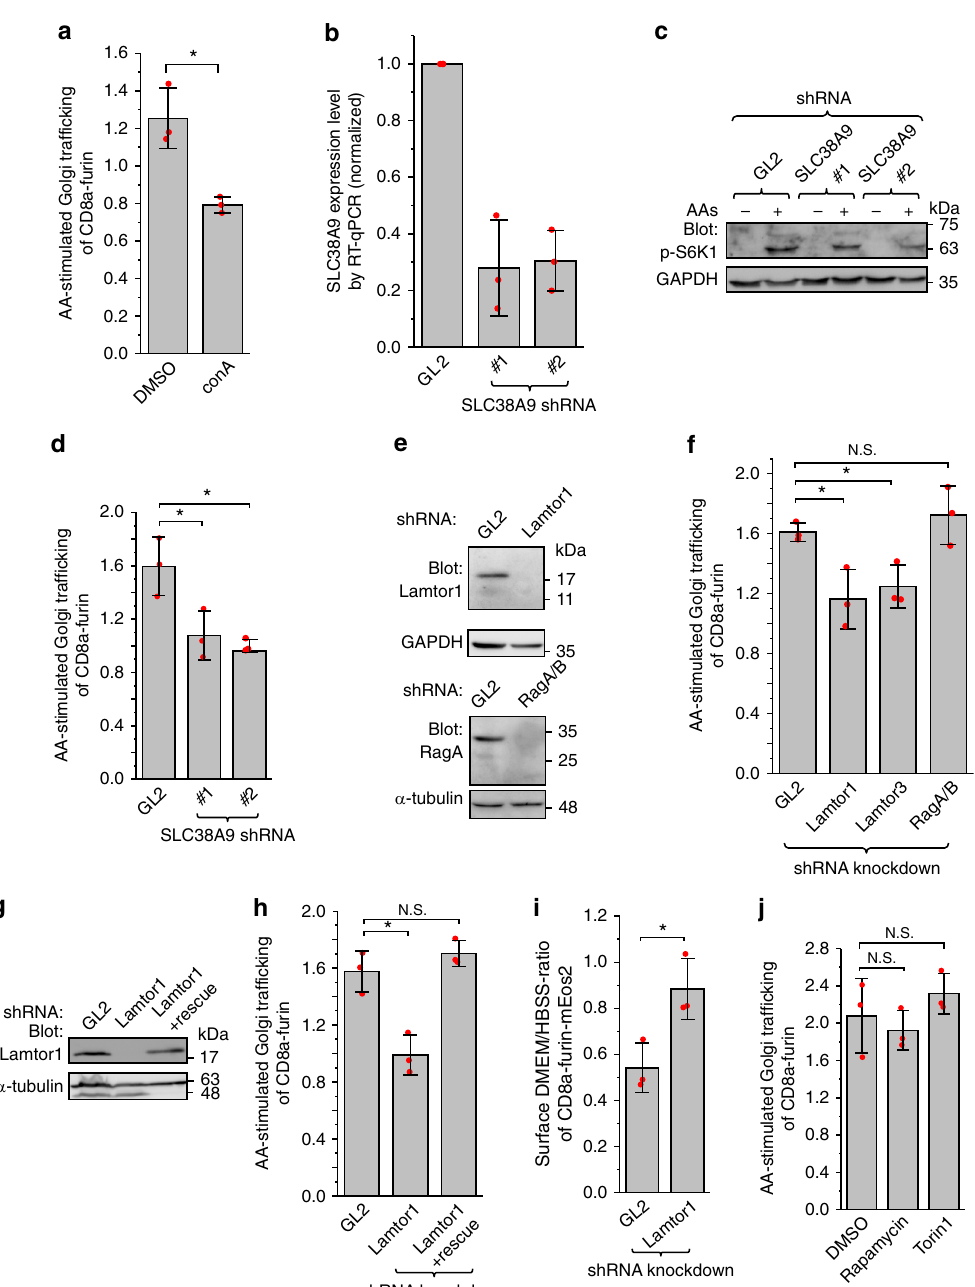
Fig. 3 Signaling components essential for the AA-stimulated retrograde traf fi cking. All cells are HeLa cells. a Cells stably expressing CD8a-furin were starved in HBSS for 2 h followed by surface-labeling and subsequent incubation with either HBSS or DMEM for 20 min. 1% DMSO or 2.5 µ M conA was present throughout the incubation. Cells were stained and the AA-stimulated Golgi traf fi cking is quanti fi ed by imaging. b Endogenous SLC38A9 was depleted by lentivirus-transduced shRNAs as assessed by RT-qPCR from n = 3 independent experiments. c The knockdown of endogenous SLC38A9 attenuated the AA-stimulated mTORC1 activity. Knockdown cells were incubated with DMEM/-AAs for 50 min followed by incubation with DMEM for 20 min. Cell lysates were immuno-blotted for phospho-S6K1 (p-S6K1) and GAPDH. d SLC38A9 is required for the AA-simulated Golgi traf fi cking. Cells treated with indicated shRNAs were transfected to express CD8a-furin and subjected to treatment and analysis similar to a . e Immuno-blots showing that endogenous Lamtor1 and RagA/B were depleted by respective lentivirus-transduced shRNAs. f Lamtor1 and 3 but not RagA/B are required for the AA- stimulated Golgi traf fi cking. The experiment was similar to d . g , h Under Lamtor1 knockdown condition similar to e , an RNAi-resistant Lamtor1 was able to express and rescue the AA-stimulated Golgi traf fi cking. i Lamtor1 is required for the AA-stimulated reduction of surface CD8a-furin-mEos2. Knockdown and surface labeling were similar to e and Fig. 2j, respectively. Surface intensity was normalized by mEos2 total intensity. Surface DMEM/HBSS-ratio is the normalized surface intensity under DMEM divided by that under HBSS treatment. j mTORC1 is not required for the AA-stimulated retrograde traf fi cking. The experiment was conducted similarly to a except that 1% DMSO, 100 nM rapamycin, or 250 nM Torin1 was present throughout the treatment. In a , b , d , f , h – j , the displayed value is the mean of n = 3 independent experiments and individual data points are shown as red dots. Error bar, mean ± s.d.; P values were from t test (unpaired and two-tailed); N.S., not signi fi cant ( P > 0.05); * P ≤ 0.05. GL2 is a non-targeting control siRNA or